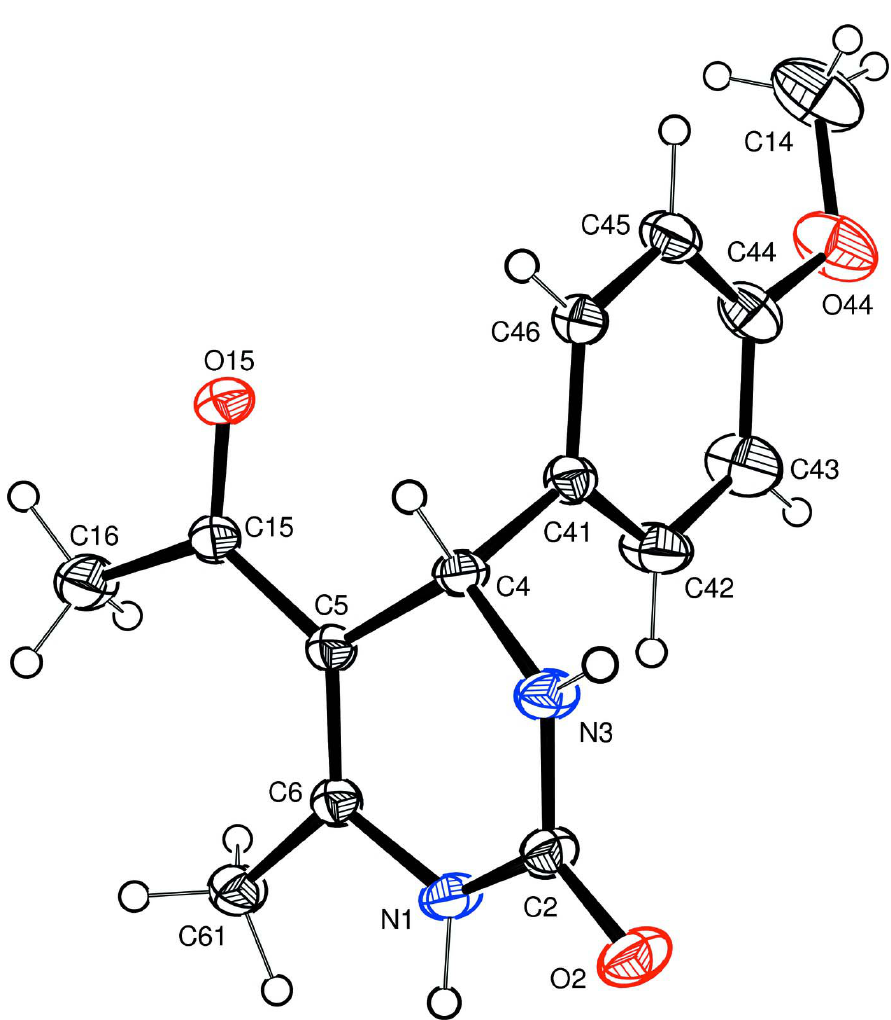
Figure 1 The molecular structure of (I) with displacement ellipsoids drawn at the 30% probability level. H atoms are shown as small spheres of arbitrary